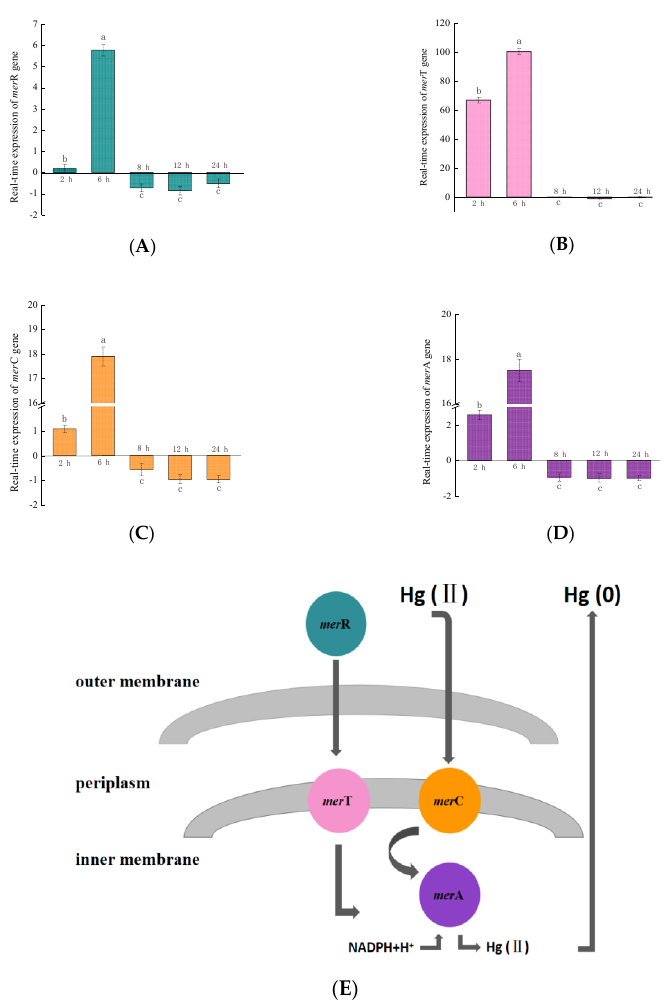
Figure 2. Real-time quantitative analysis of the principal genes, ( A ) mer R, ( B ) mer T, ( C ) mer C, and ( D ) mer A, in the mer operon of the RTS-4 bacterial strain at different times. ( E ) Hg(II) reduction mechanism in the RTS-4 bacterial strain. Bars (means values ± SD) with different letters are sig- nificantly different from the three independent experiments at the 0.05 level, according to LSD multiple